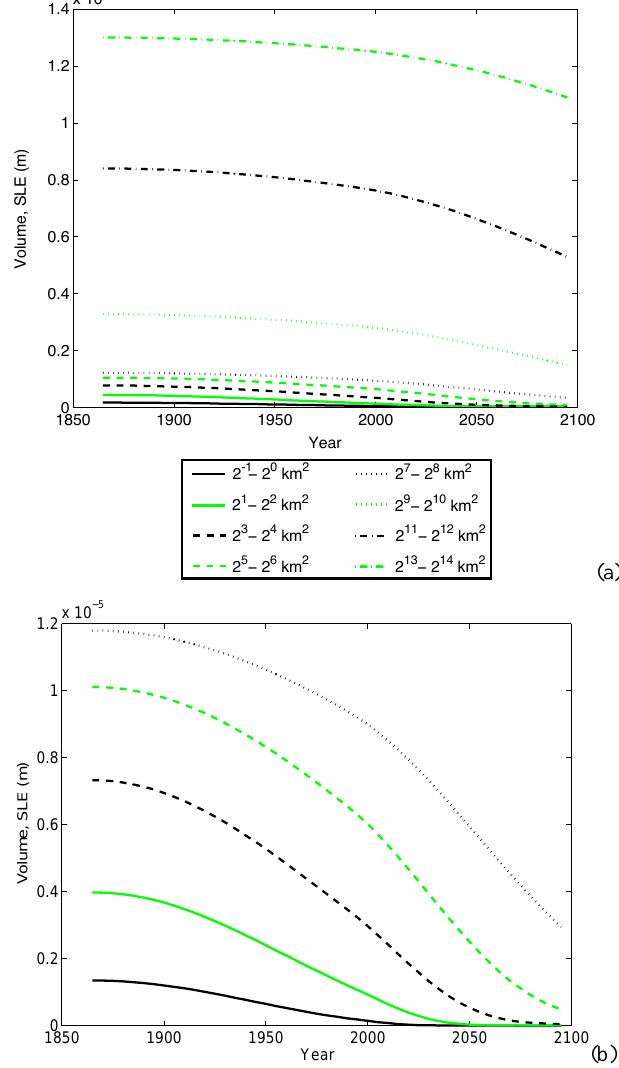
Fig. 4. Volume evolution (m) in time for (a) every second size class for reference experiment R10 and (b) close-up of the smallest 5 size classes in (a) .